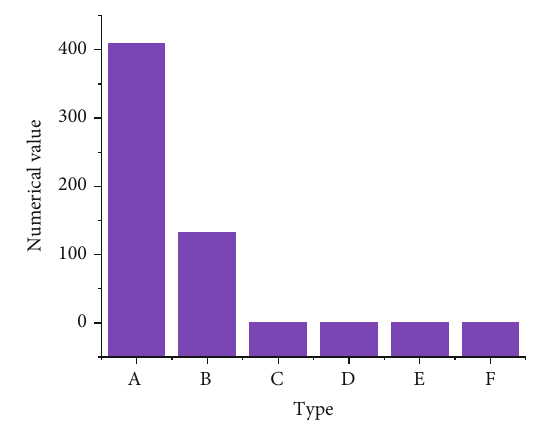
Figure 5: Fitting detection (A: λ 2 ); B: Df ; C: goodness of fi tting index; D: comparison of the fi tting index; E: fi tting index model; and F: root mean square of the approximation